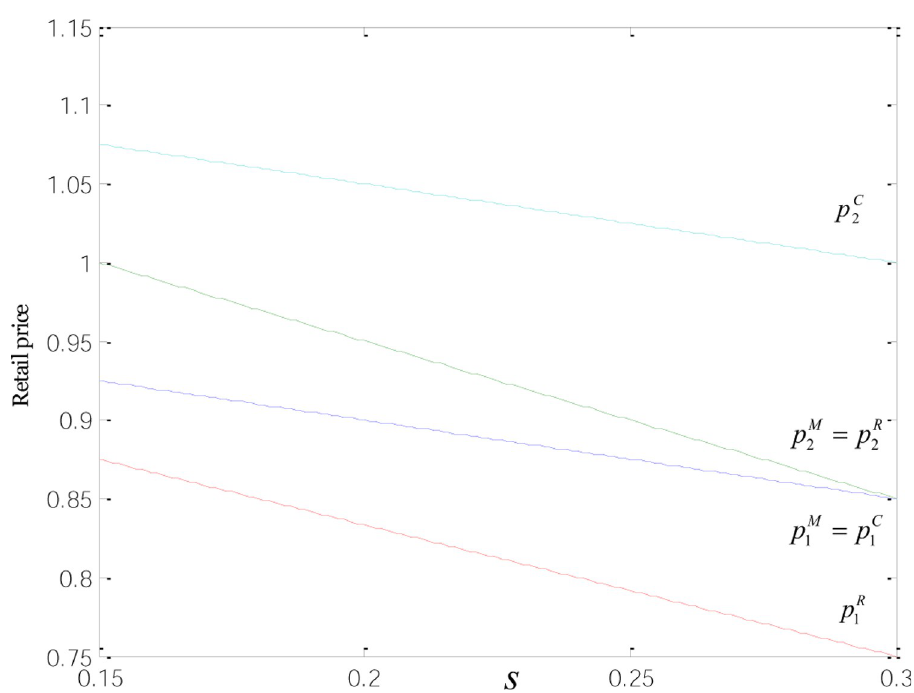
Fig 3. Relationships between the retail price and low-carbon subsidies.